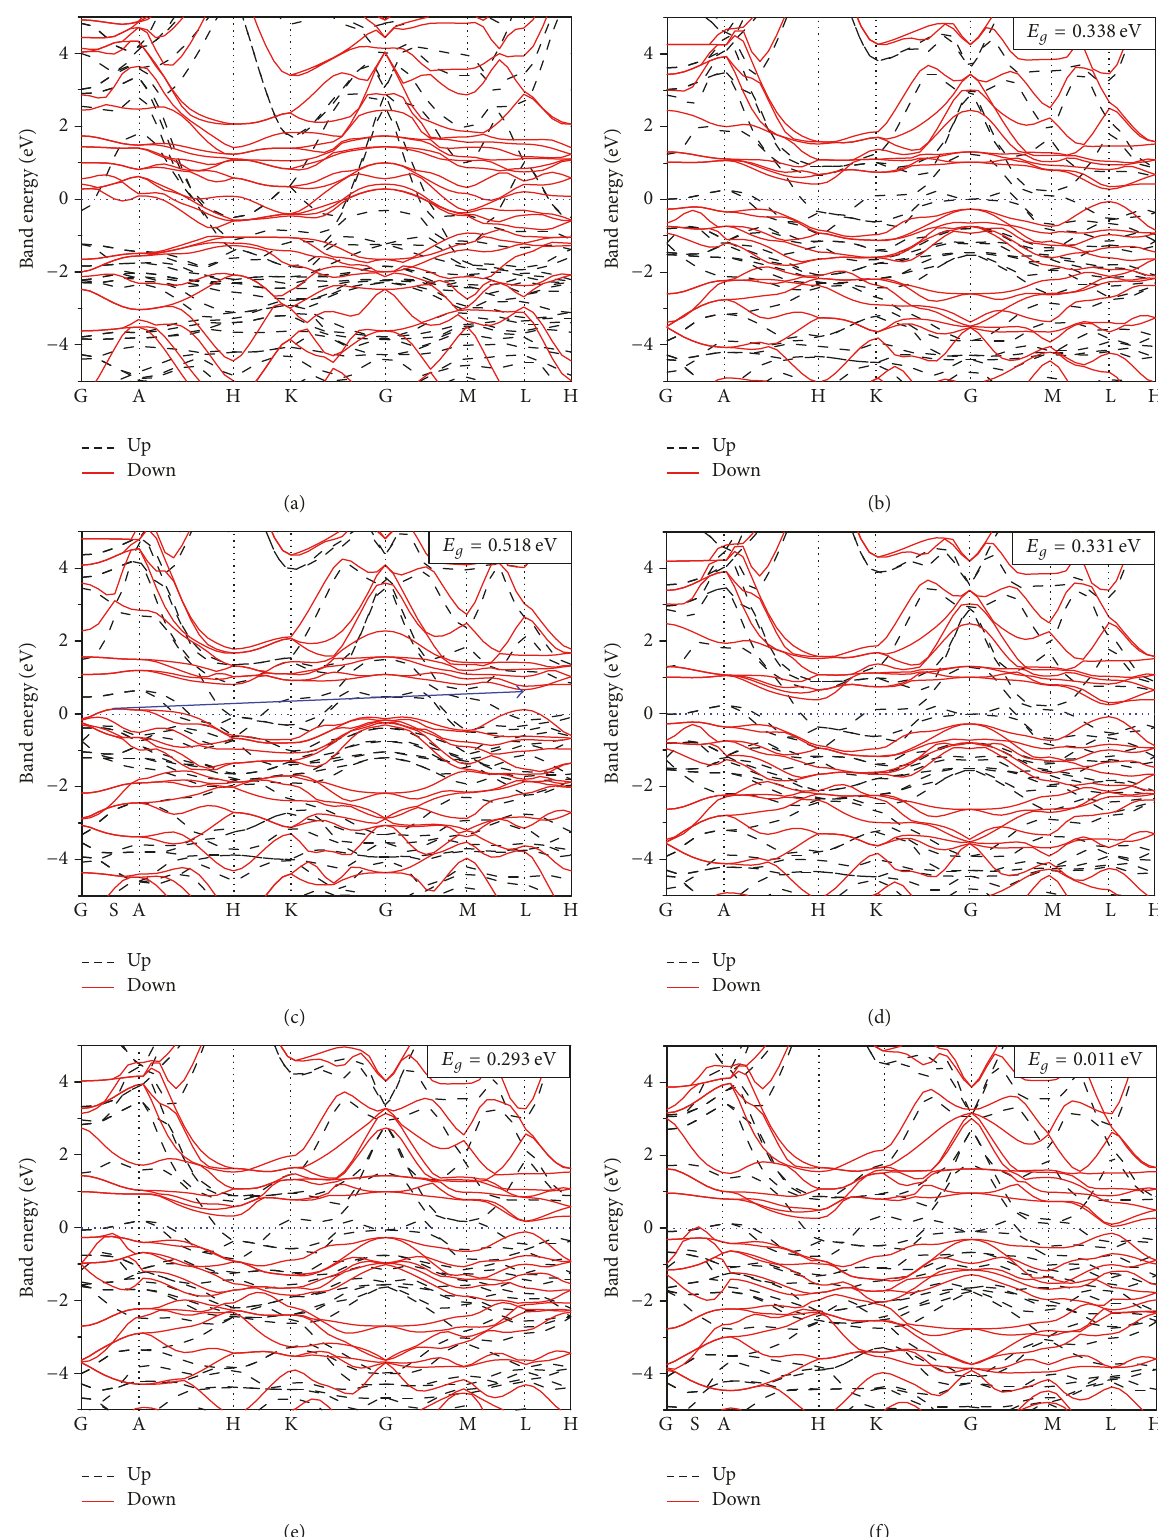
Figure 1: Band structures of Fe 2 Si under various strains: (a) − 12%, (b) − 7%, (c) 0%, (d) 5%, (e) 9%, and (f) 12%. The band structure of spin- down electrons has indirect bandgap semiconductor character. The valence band maximum is 0.164 eV at point S and the conduction band minimum is 0.682 eV at the BZ point L. The blue arrow is from the top of the valence band point to the bottom of the conduction